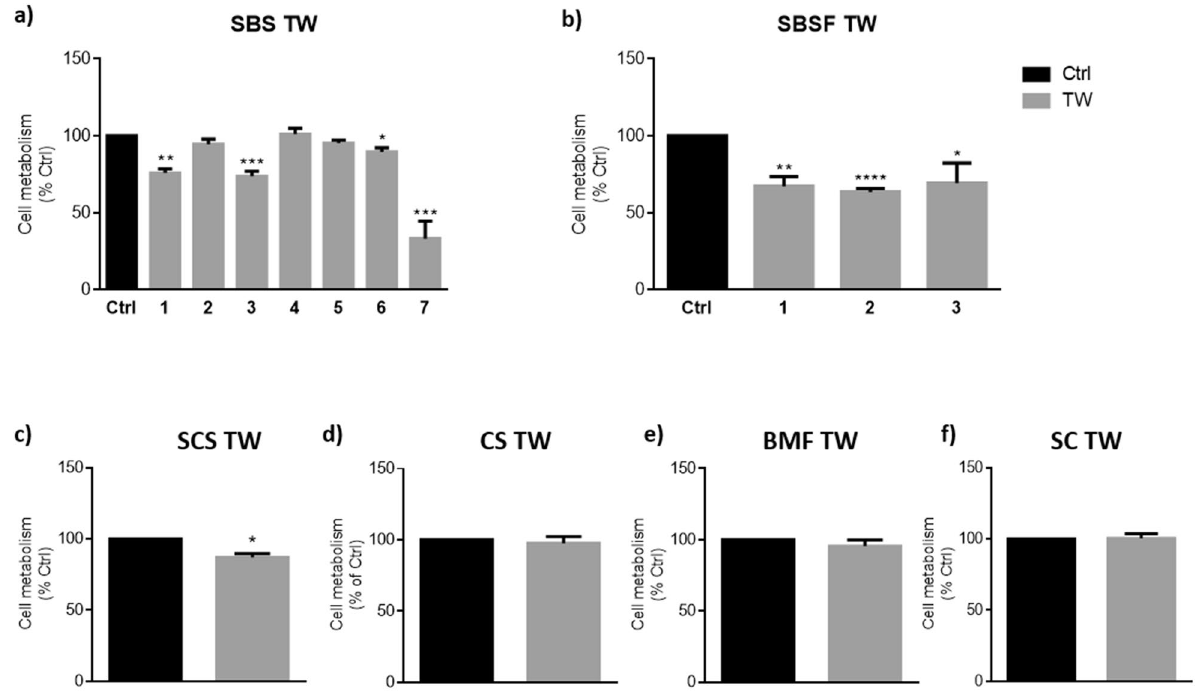
Figure 1. Thermal waters effect on macrophages metabolic state. Cells were plated and exposed to Ctrl medium or SBS ( a ), SBSF ( b ), SCS ( c ), CS ( d ), BMF ( e ) and SC ( f ) thermal waters (TW) for 24 h. Alamar blue assay was further performed to assess cell metabolism. Data correspond to the means ± SEM of at least three independent experiments and are represented as % of control cells (Ctrl, black bars). Statistical analysis: Unpaired t-test; p < 0.05 was considered significant: * p < 0.05, ** p < 0.01, *** p < 0.001, **** p < 0.0001, compared to Ctrl. Legend: SBS sulphurous/bicarbonate/sodic, SBSF sulphurous/bicarbonate/sodic/fluoridated, CS chlorinated/sodic,